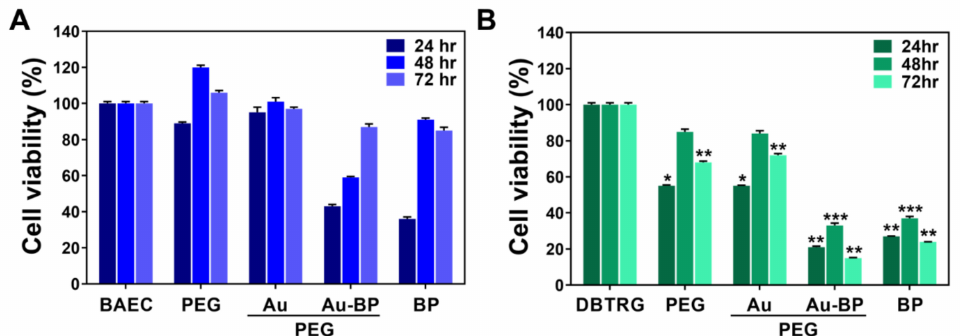
Figure 3. Biocompatibility assessment for BAEC and DBTRG cell lines investigated by MTT assay. Cytotoxicity test between ( A ) BAEC and ( B ) DBTRG brain cancer cell lines treated with pure PEG, PEG-Au, PEG-Au-BP, and pure BP for 24, 48, and 72 h. The semi-quantified result of BAEC cell growth was inhibited by PEG-Au-BP and pure BP, but with no significant difference. However, the cell viability of DBTRG brain cancer cells was significantly lower in PEG-Au-BP and pure BP treatments compared to control, indicating that the PEG-Au-BP could be a potential nanodrug to inhibit cancer cell proliferation. * p < 0.05, ** p < 0.01, *** p < 0.001: compared to the control group (BAEC and